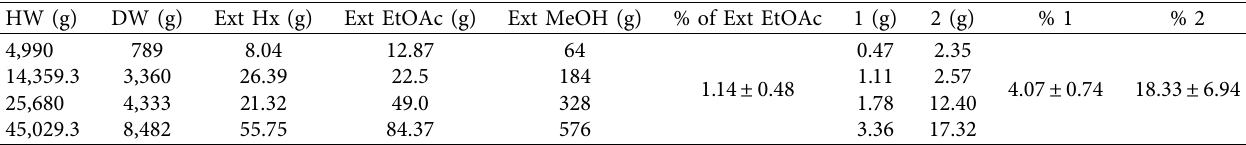
Table 1: Yield of 23,24-dihydrocucurbitacin D (1) and 2-(O- β -D-glucopyranosyl)-23,24-dihydrocucurbitacin D (2) after ethyl acetate extraction from the root of Ibervillea lindheimeri .